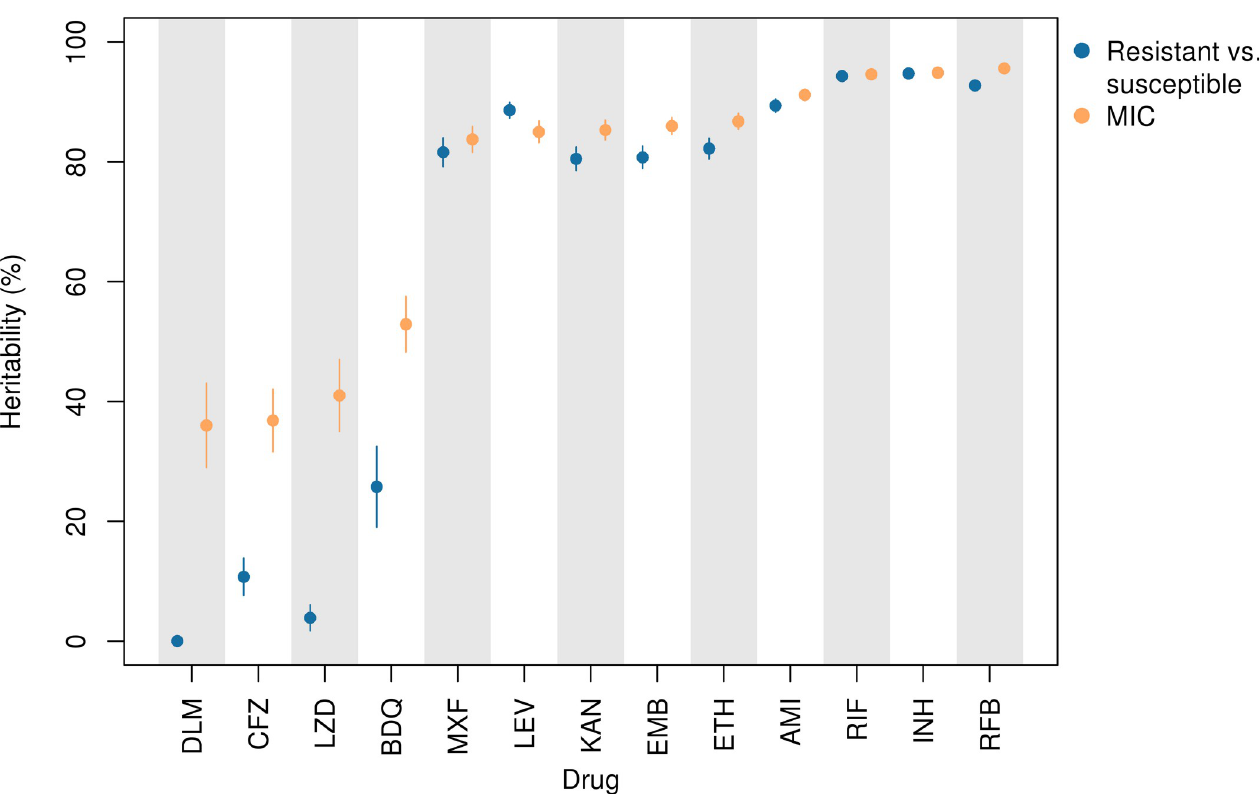
Fig 2. Sample heritability for MIC (orange) versus binary resistance/sensitivity (blue) assuming additive genetic variation in oligopeptide presence/ absence across 13 drugs, DLM, CFZ, LZD, BDQ, MXF, LEV, KAN, EMB, ETH, AMI, RIF, INH, and RFB. Lines depict 95% CIs. MIC heritability was at least 26% higher than binary heritability for the new and repurposed drugs BDQ, CFZ, DLM, and LZD. AMI, amikacin; BDQ, bedaquiline; CFZ, clofazimine; CI, confidence interval; DLM, delamanid; EMB, ethambutol; ETH, ethionamide; INH, isoniazid; KAN, kanamycin; LEV, levofloxacin; LZD, linezolid; MIC, minimum inhibitory concentration; MXF, moxifloxacin; RFB, rifabutin; RIF,